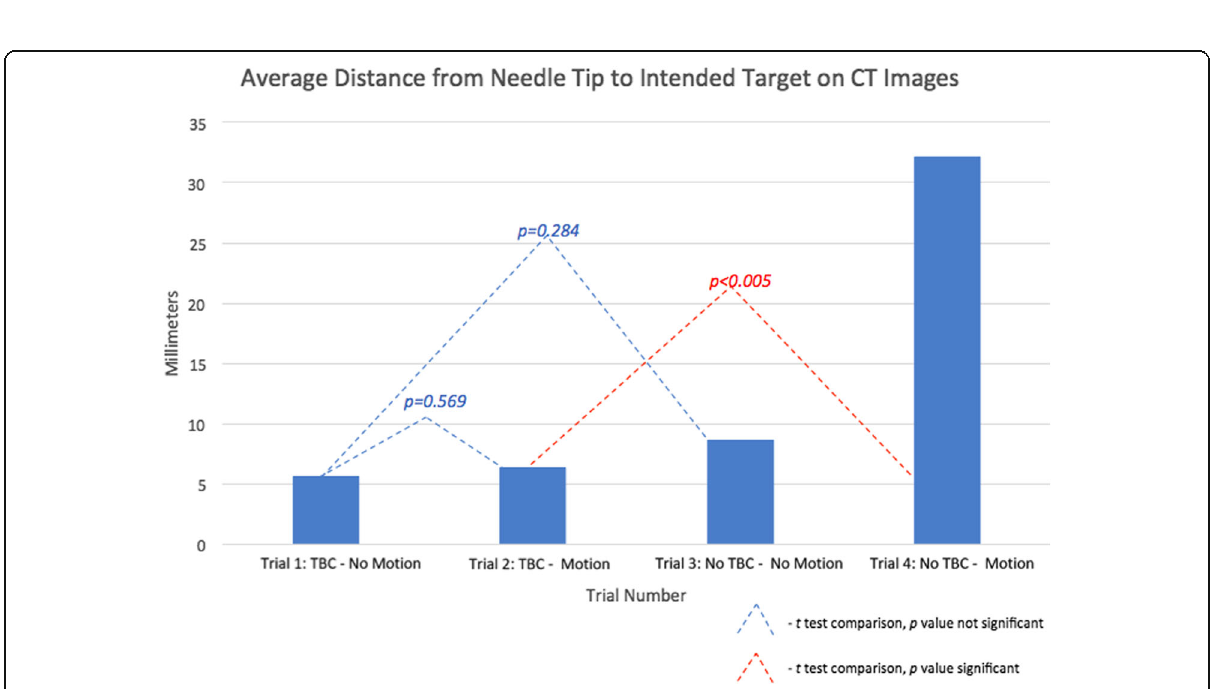
Fig. 9 Average system error and comparisons for trials 1 to 4. System error was defined as the distance from the tip of the needle, placed under fusion image guidance, to the location of the intended target. Trials vary the presence/absence of the TFC and motion (see text)